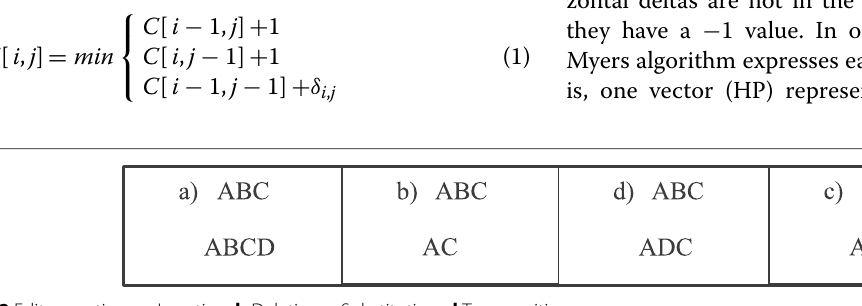
Fig. 2 Edit operations. a Insertion. b Deletion. c Substitution. d